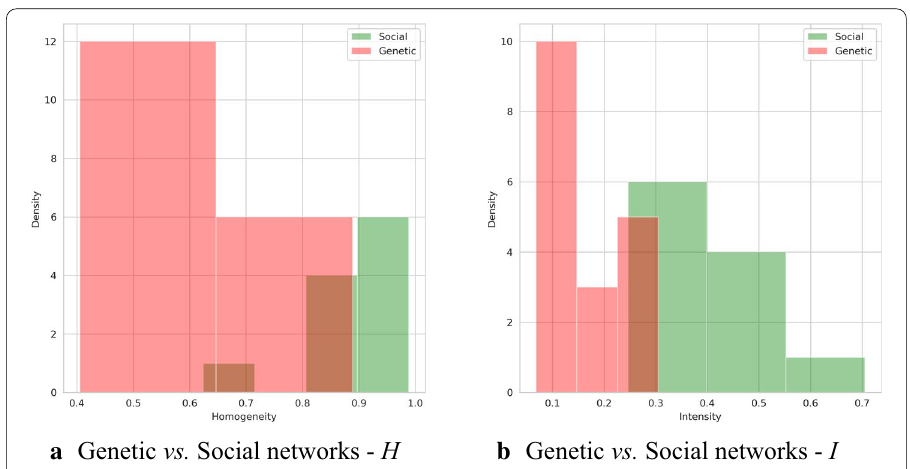
Fig. 15 Distributions of homogeneity and intensity when genetic networks are compared to social